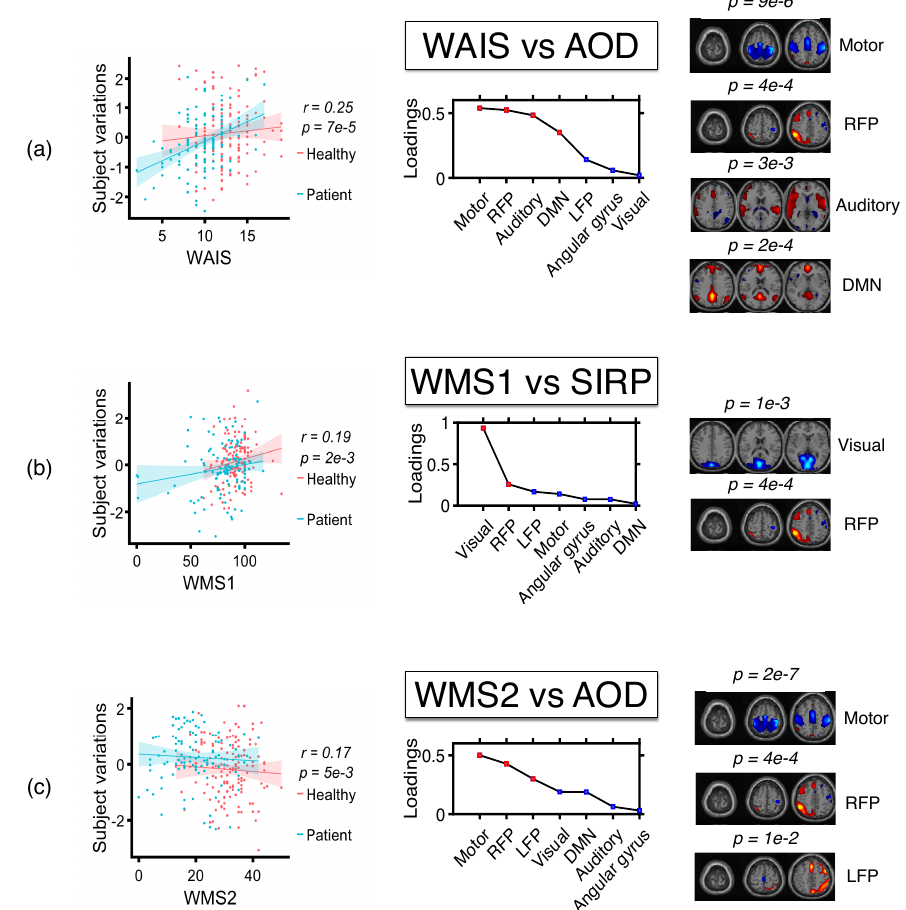
Figure 8. Behavioral features and subject profiles identified as correlated by ac-IVA. Here, ( a ) WAIS is correlated with the profiles associated to motor, RFP, auditory, and DMN components in the AOD task; ( b ) WMS1 is correlated with the profiles associated with visual and RFP components in the SIRP task; and finally, ( c ) WMS2 is correlated with the profiles associated to motor, and FP components in the SM